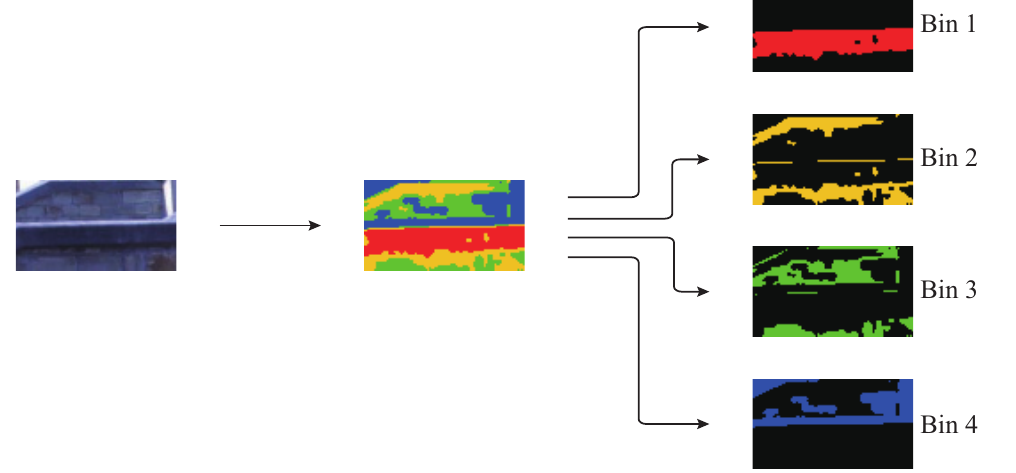
Figure 3. Demonstration of sub-region